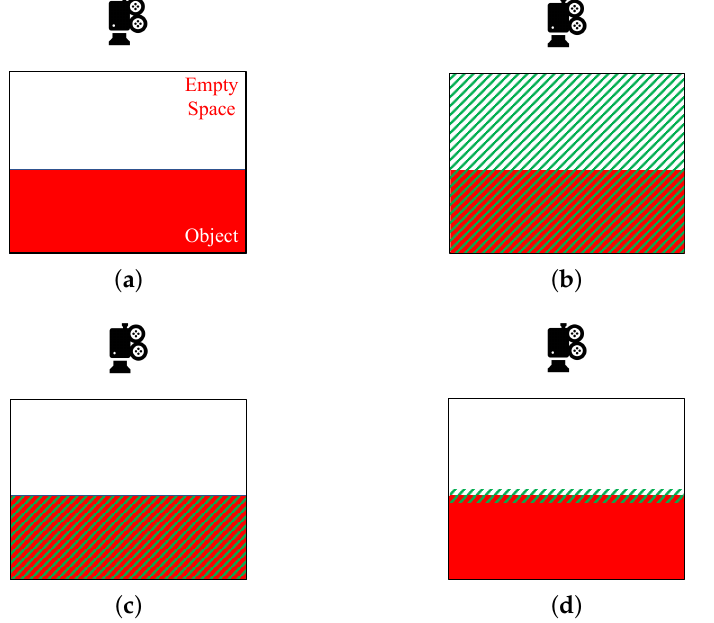
Figure 4. The focus regions of the loss functions (green masks for the focus regions). ( a ) The illustration of the example scene, where one object exists. ( b ) The scene loss. ( c ) The object loss. ( d ) The surface